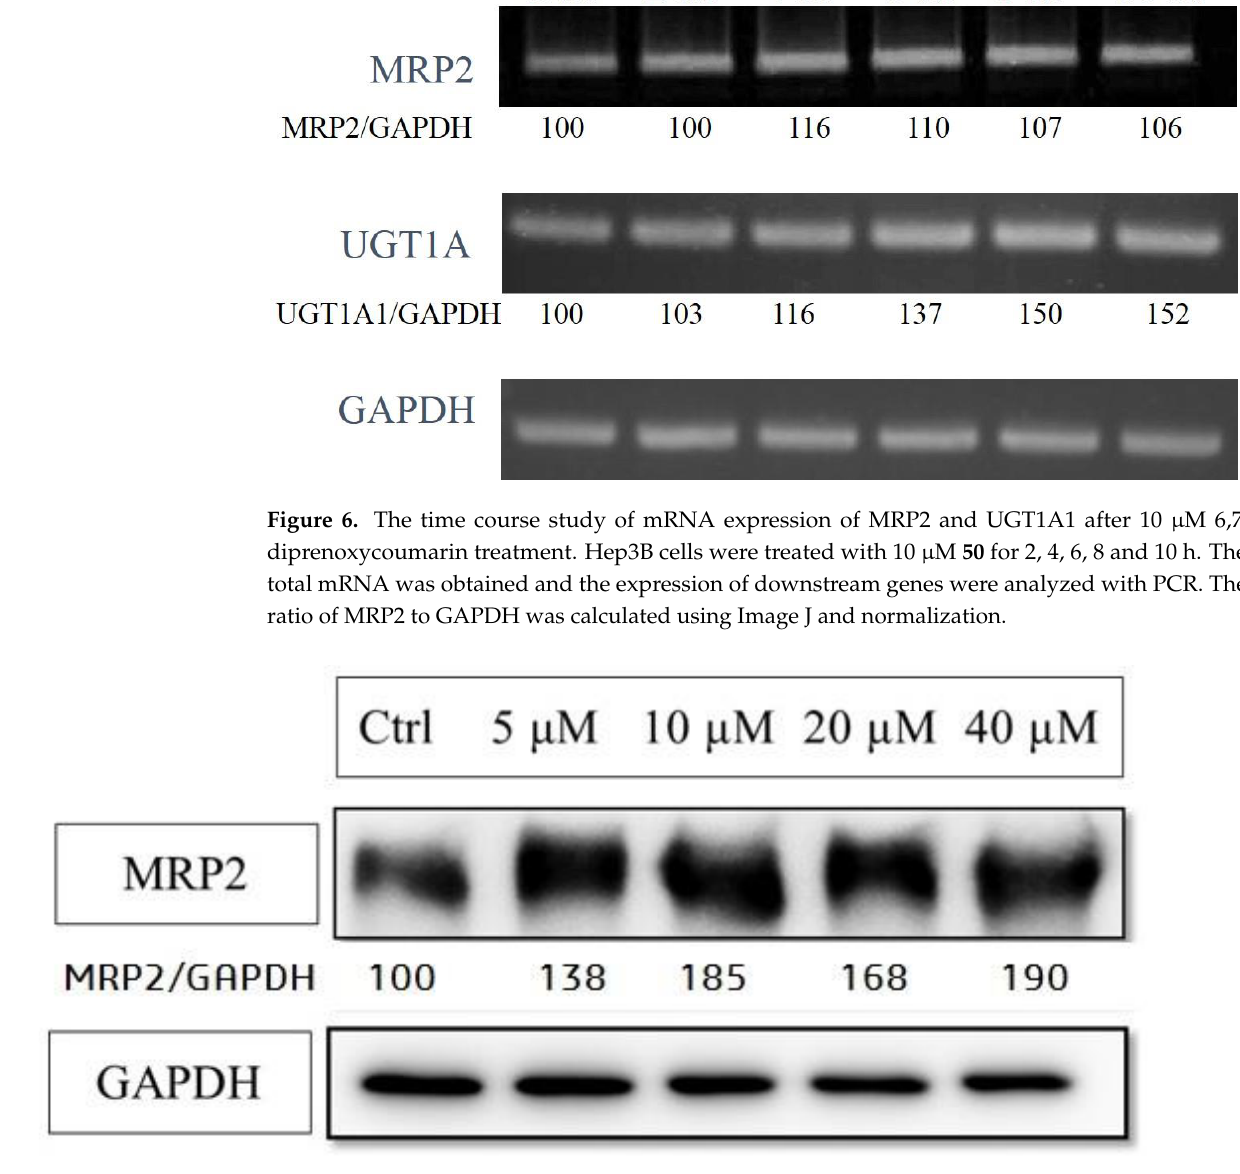
Figure 7. The protein expressions of MRP2 after 6,7-diprenoxycoumarin ( 50 ) treatment. Hep3B cell (1 × 10 6 ) were treated with 50 (5, 10, 20 and 40 µ M) for 24 h. Treated cell lysates were prepared as described in the Methods section and the expression of MRP2 was analyzed by western blot.